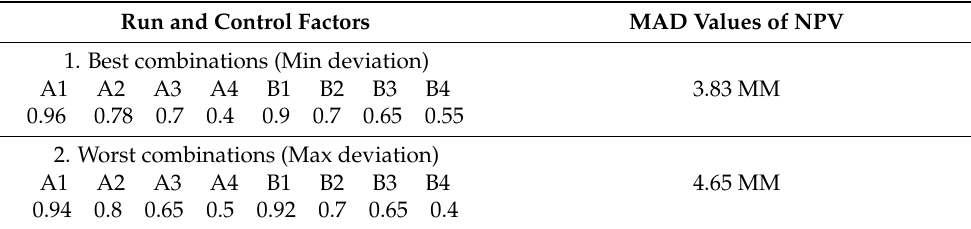
Table 10. Mean absolute deviation (MAD) values for random prices (1000